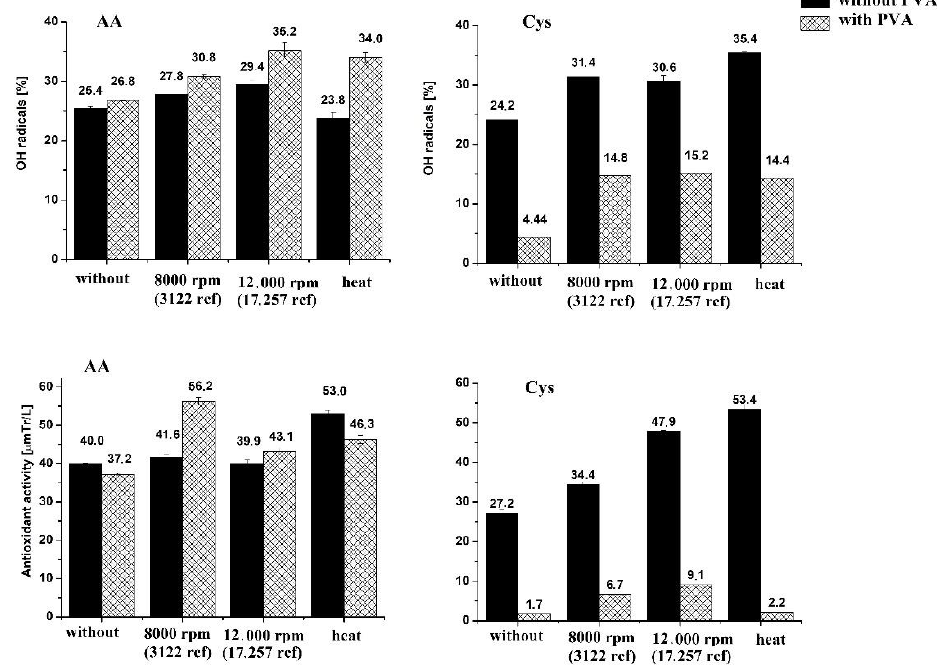
Figure 5. The antioxidant activity of the obtained SeNPs.